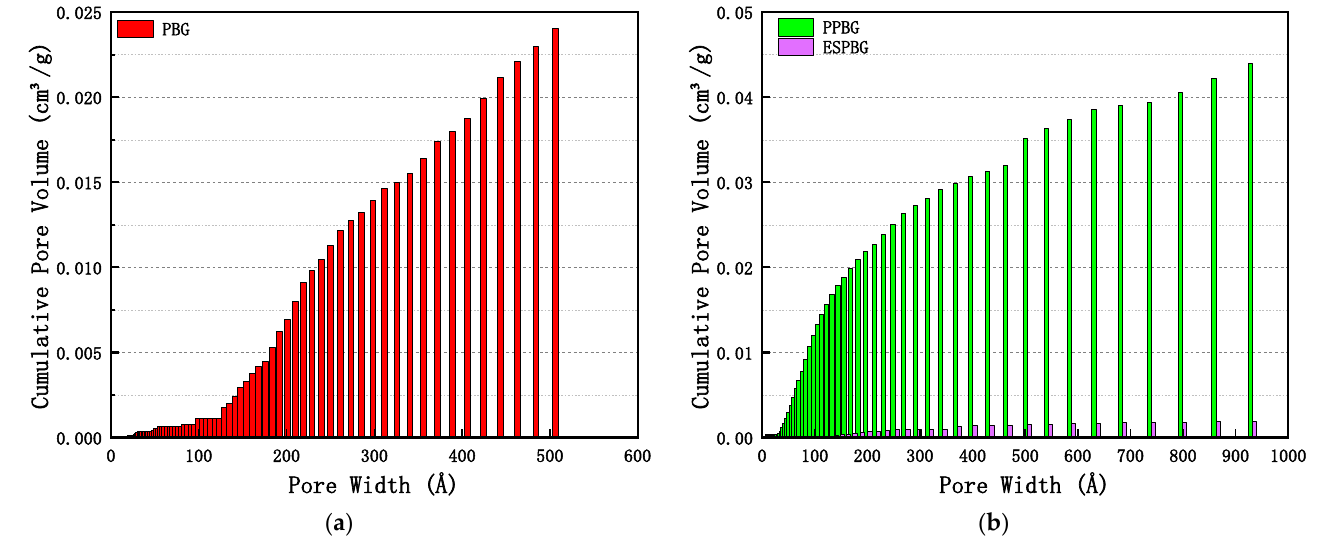
Figure 12. Cumulative pore volumes of the ( a ) PBG and the ( b ) PPBG and ESPBG.